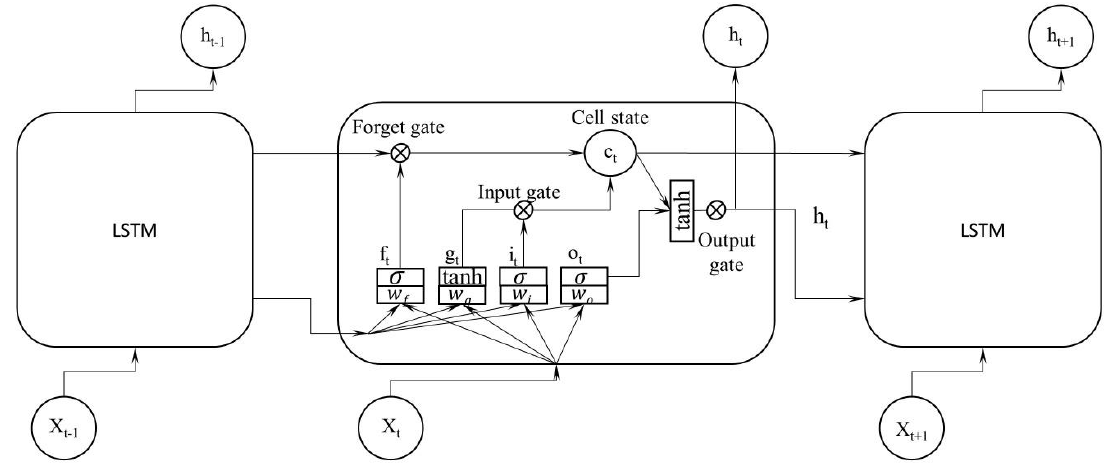
Figure 4. Structure of the LSTM model with time-series data.